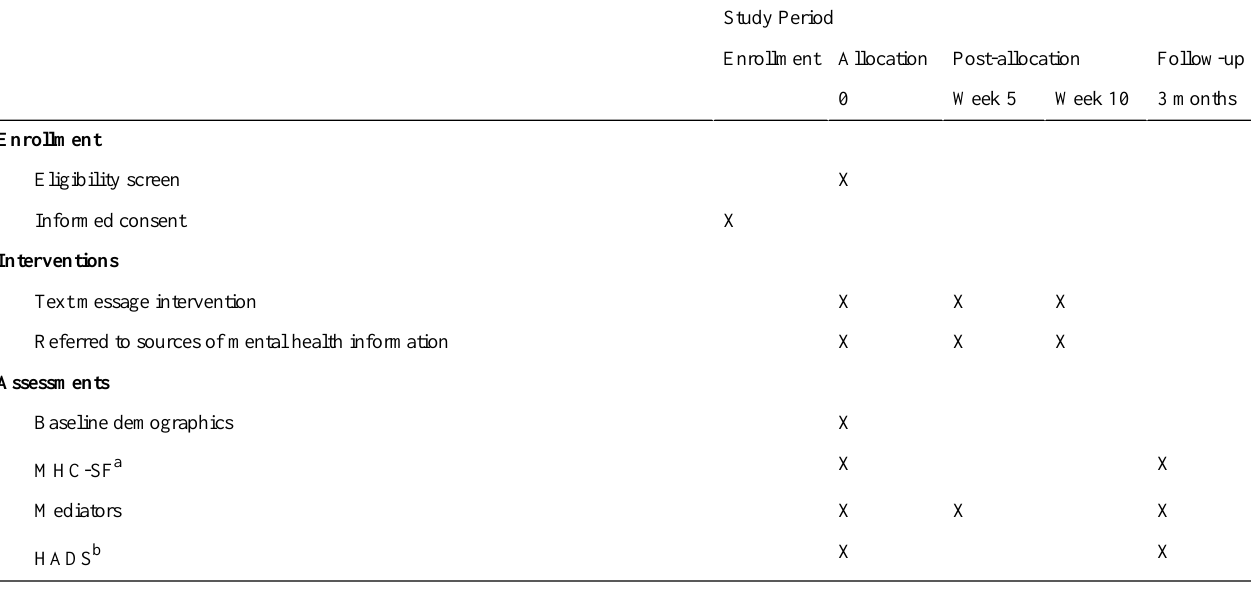
Table 1. SPIRIT checklist depicting study procedures, measurements, and timeline.